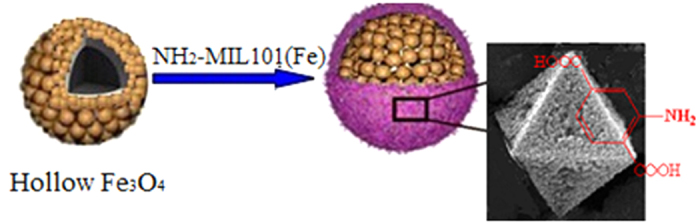
Representative illustration of the formation of hollow porous magnetic Fe3O4@NH2-MIL-101(Fe).